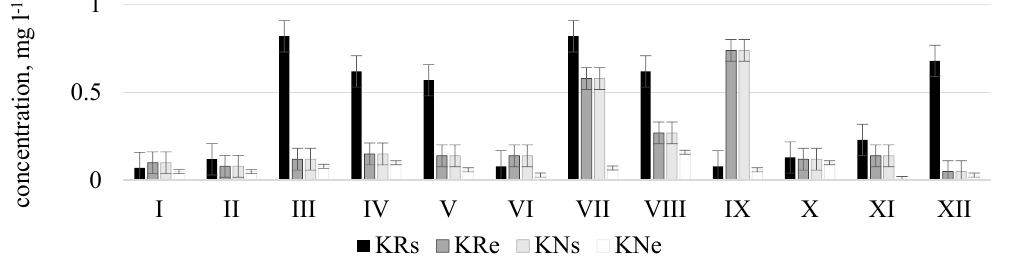
− Figure 8. Phosphate concentrations (PO 3 ) in natural (N) and regulated (R) stretches of Kuosin˙e 4 Figure 8. Phosphate concentrations ( PO (cid:2872)(cid:2871)(cid:2879) ) in natural (N) and regulated (R) stretches of Kuosin ė stream. Figure 8. Phosphate concentrations ( PO (cid:2872) (cid:2871)(cid:2879) ) in natural (N) and regulated (R) stretches of Kuosin ė stream. Figure 8. Phosphate concentrations ( PO (cid:2872)(cid:2871)(cid:2879) ) in natural (N) and regulated (R) stretches of Kuosin ė stream.